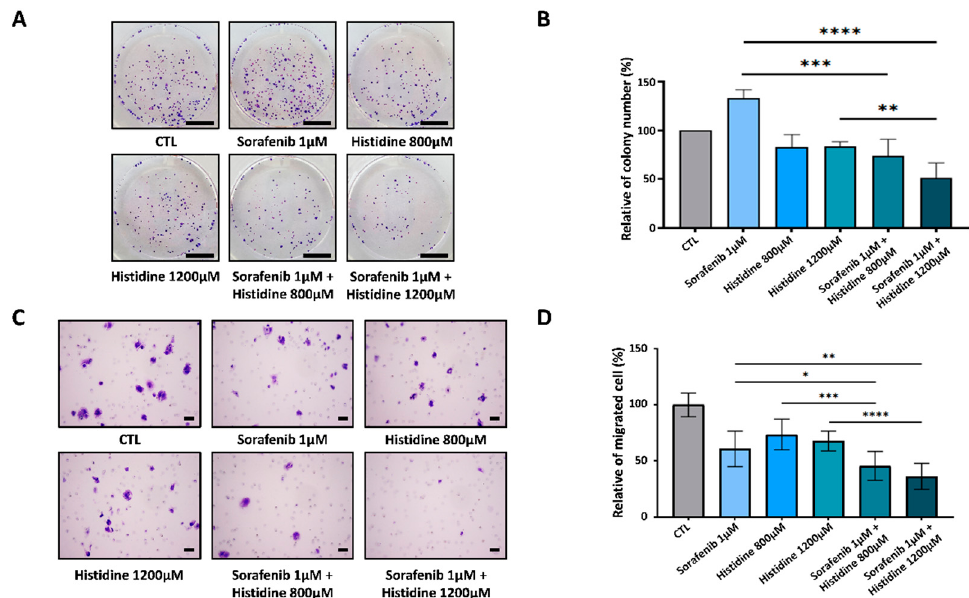
Figure 5. The anti-cancer effect of the combined treatment with sorafenib and histidine. ( A ) A colony-formation assay was performed in HepG2 cells treated the combination of 1 µ M sorafenib and 800 µ M or 1200 µ M L-histidine in EBSS media under hypoxia (1% oxygen) for 24 h. After treatment, cells were changed to normal growth media. After 3–4 weeks, cells were fixed and stained with crystal violet. Scale bars: 1 cm ( B ) Quantitative analyses were performed to determine relative colony numbers. Data are shown as the mean of three independent experiments ± SD. Statistical analyses were performed using GraphPad Prism and comparisons between groups were made using ANOVA with Tukey’s multiple comparisons tests. * p < 0.05; ** p < 0.01; *** p < 0.001; **** p < 0.0001 . ( C ) A migration assay was conducted with HepG2 cells. Inserted HepG2 cells were treated with the indicated condition. After 24 h incubation under hypoxia, cells were fixed and stained with crystal violet. Scale bars: 20 µ m ( D ) Bar graphs show relative migrated cells Data are shown as the mean of three independent experiments ± SD. Statistical analyses were performed using GraphPad Prism and comparisons between groups were made using ANOVA with Tukey’s multiple comparisons tests. * p < 0.05; ** p < 0.01; *** p < 0.001; **** p < 0.0001 .